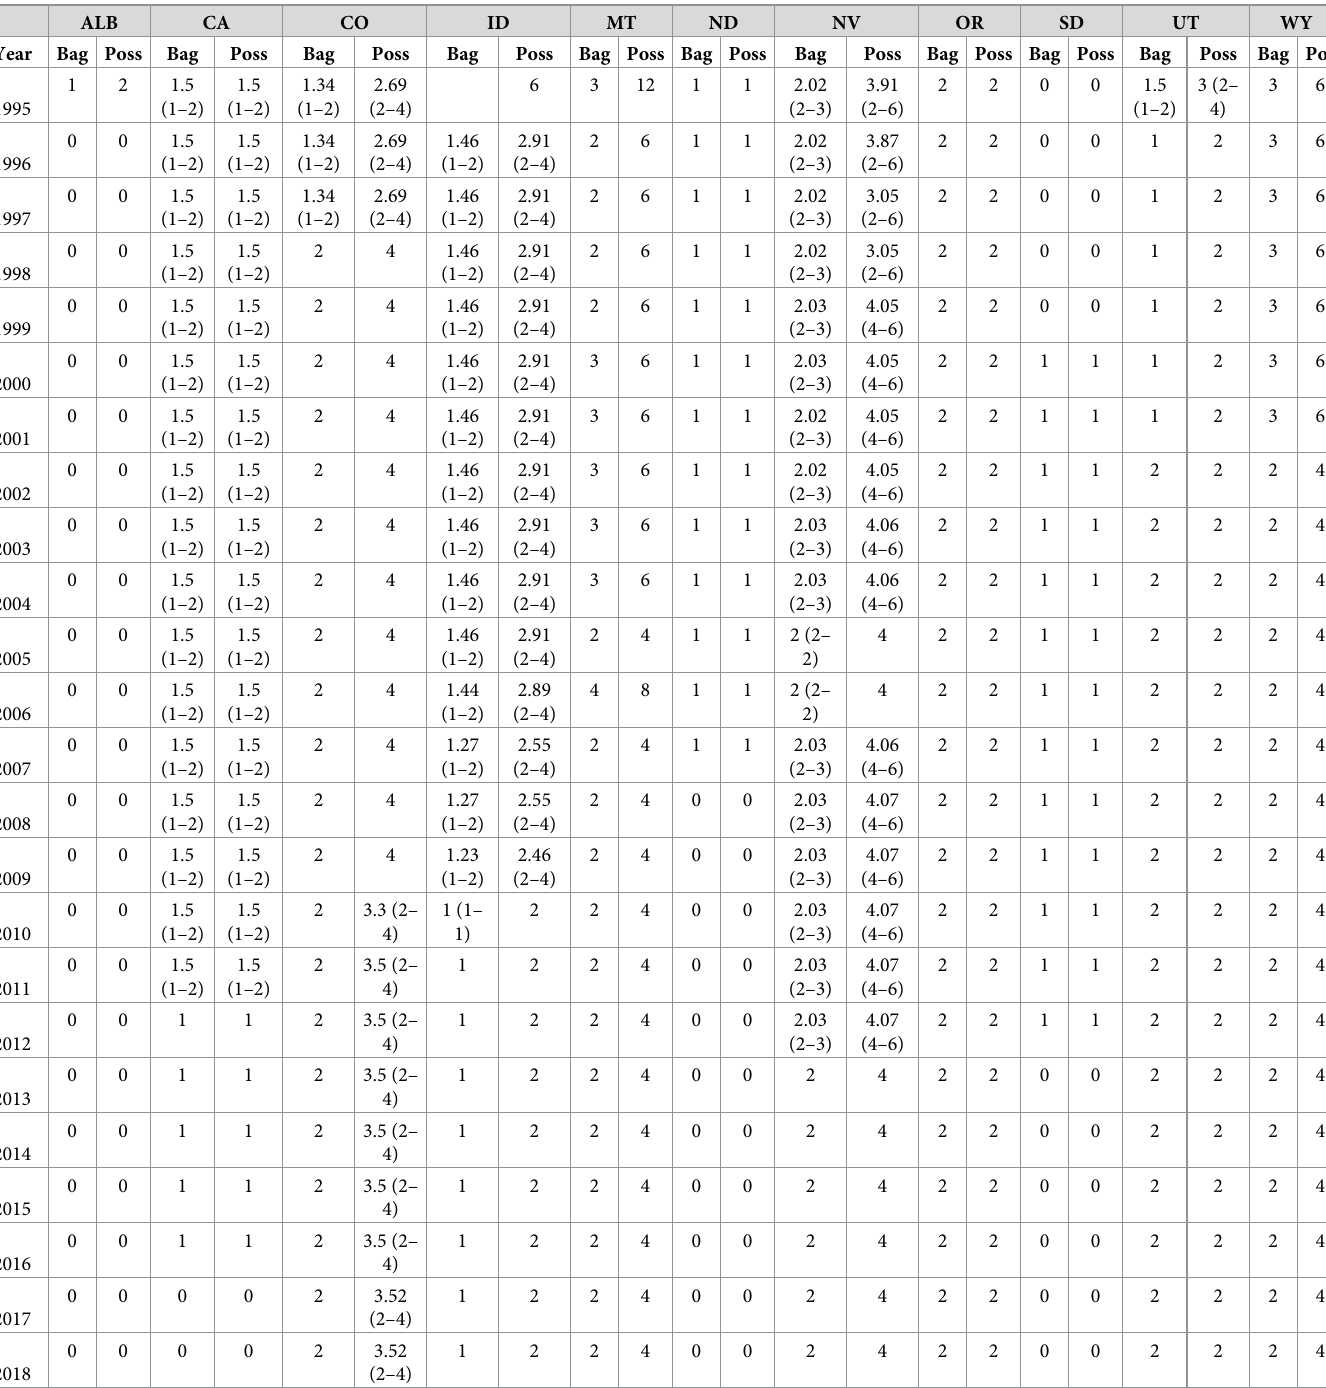
Table 1. Area-weighted average daily bag (Bag) and possession (Poss) limits for states and provinces open to hunting greater sage-grouse between 1995–2018. Blank cells indicate closures in given years. Where bag or possession limits varied within a state, minimum and maximum values are presented in parentheses.